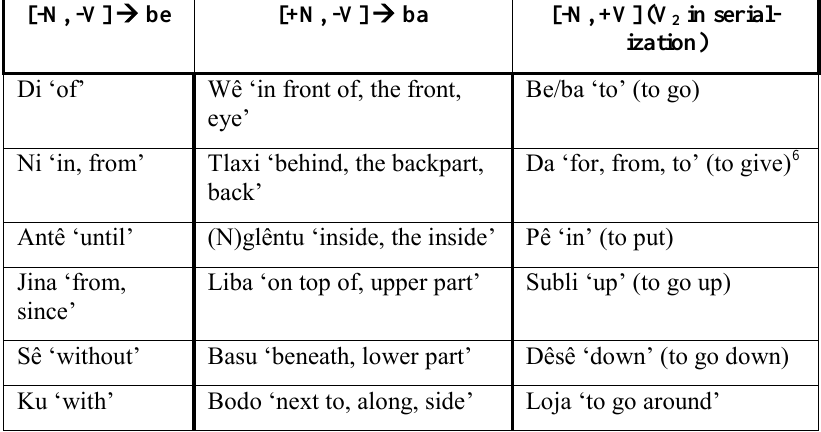
Table II. Lexical items with ‘prepositional functions’